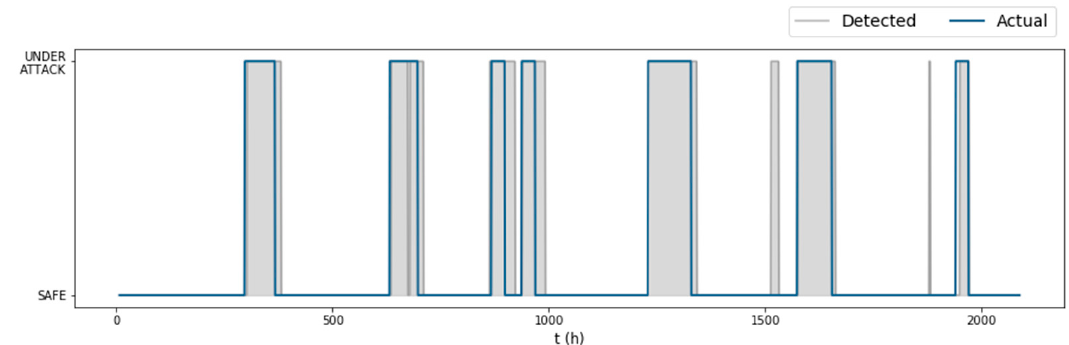
Figure 6. Algorithm performance on the test dataset ( 𝐷𝑎𝑡𝑎𝑠𝑒𝑡 3 of BATADAL).